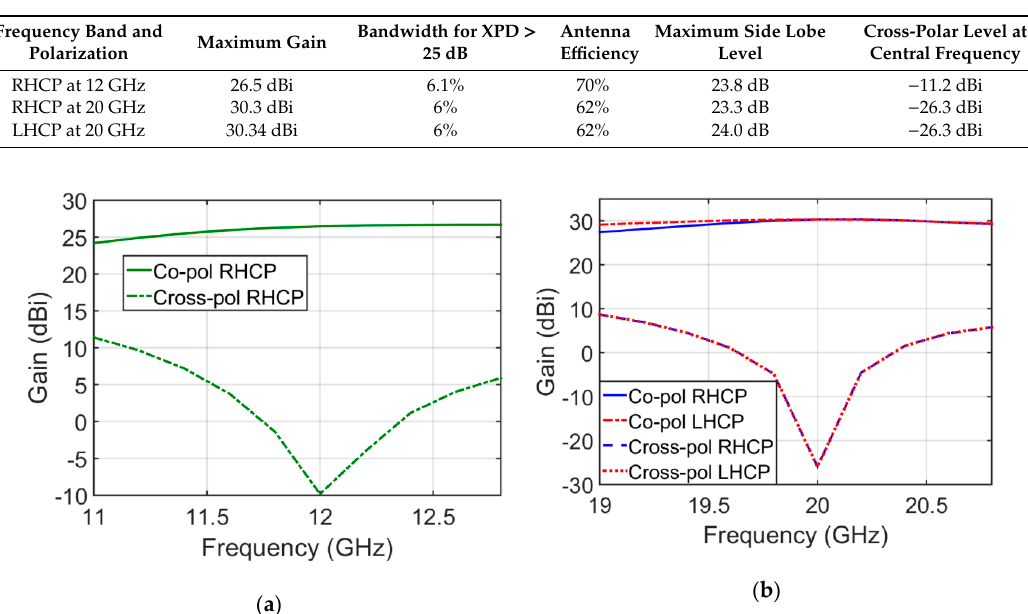
Figure 10. Simulated radiation patterns in elevation plane at 12 GHz for RHCP and 20 GHz for both RHCP and LHCP provided by designed reflectarray that radiates three circular polarization focused beams. We have analyzed this last design reflectarray by taking into account tolerance errors of 5% variation of permittivity (i.e., ε r1 = ε r2 = 2.31) and +/ − 0.05 mm variations of the lengths of dipoles and arcs. These tolerance errors are higher than typical for dielectric layers material [20] and tolerance errors of mechanical PCB milling [31] in order to include the worst-case manufacturing scenario. These variations of length have been randomly added in each element of reflectarray. In Figure 11, a comparison of the resultant radiation patterns taking into account the tolerance errors and radiation patterns obtained in the elevation plane of Figure 10 is shown: